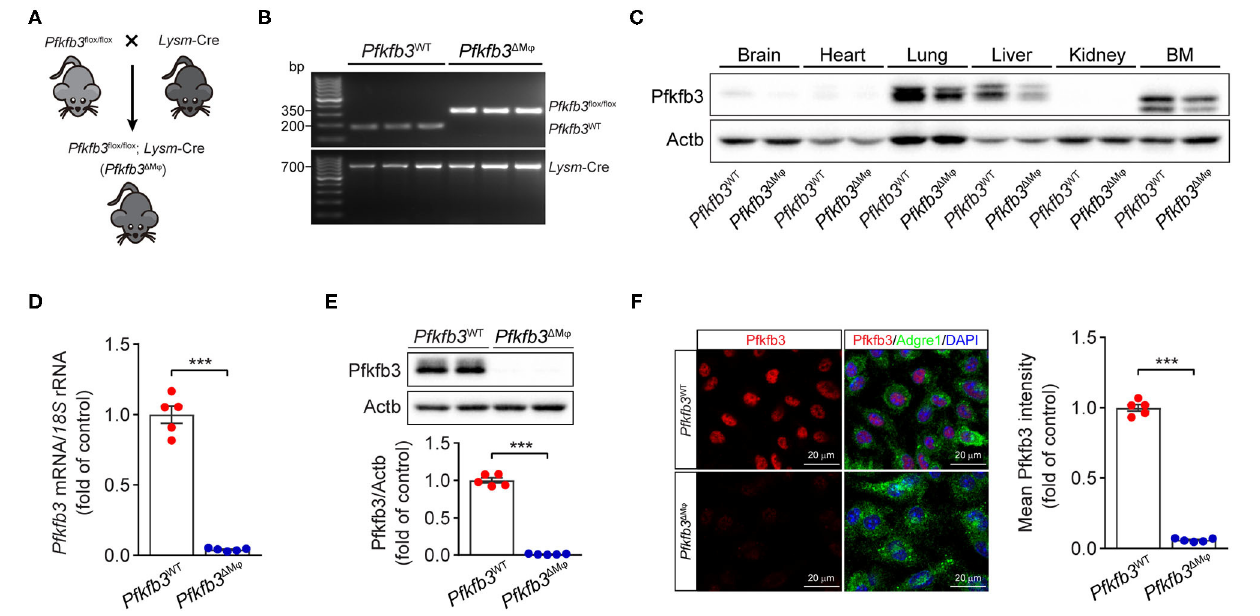
FIGURE 2 | Generation and characterization of myeloid-specific Pfkfb3 -deficient mice. (A) Diagram of the generation of myeloid-specific Pfkfb3 -deficient mice ( Pfkfb3 1 M φ ) by crossing Pfkfb3 flox / flox mice with Lysm -Cre mice. (B) Representative genotyping PCR results of Pfkfb3 WT mice and Pfkfb3 1 M φ mice. (C) Representative Western blot results of Pfkfb3 and Actb in bone marrow (BM) and main organs of Pfkfb3 WT and Pfkfb3 1 M φ mice. (D) qPCR analysis of Pfkfb3 expression in BMDMs of Pfkfb3 WT mice and Pfkfb3 1 M φ mice ( n = 5). (E) Representative Western blot results of Pfkfb3 and Actb in BMDMs of Pfkfb3 WT mice and Pfkfb3 1 M φ mice (top) and relative ratio of Pfkfb3/Actb (bottom) were quantitated by densitometric analysis of the corresponding Western blots ( n = 5). (F) Representative images (left) of triple immunofluorescence for Pfkfb3 (red), Adgre1 (green) and nuclei (DAPI, blue), and quantification (right) of Pfkfb3 expression in BMDMs of Pfkfb3 WT mice and Pfkfb3 1 M φ mice ( n = 5). All data are represented as mean ± SEM, *** P < 0.001 for Pfkfb3 WT vs. Pfkfb3 1 M φ (unpaired two-tailed Student’s t